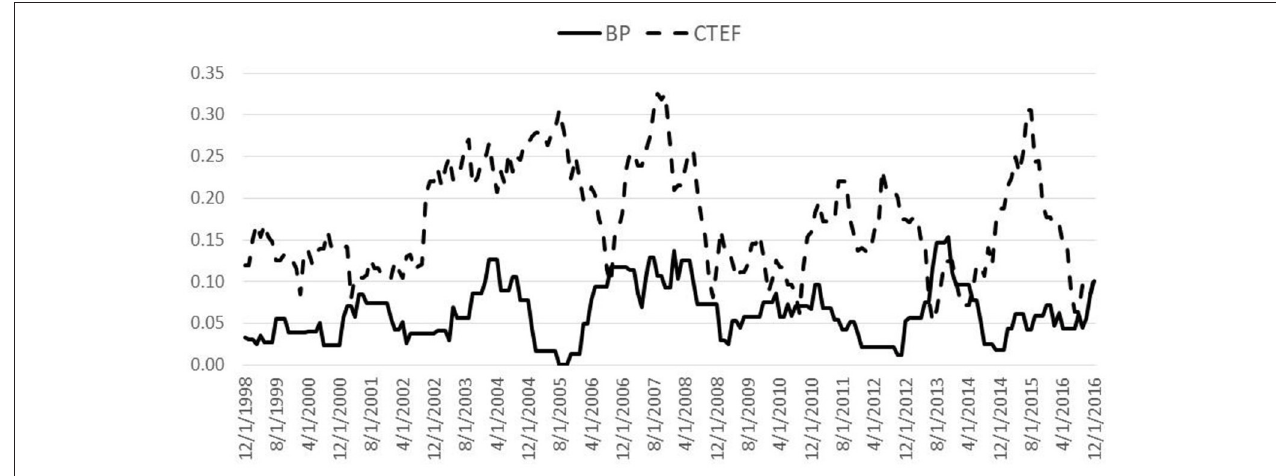
FIGURE 1 | Time series of regression coefficients on BP and CTEF variables (EM